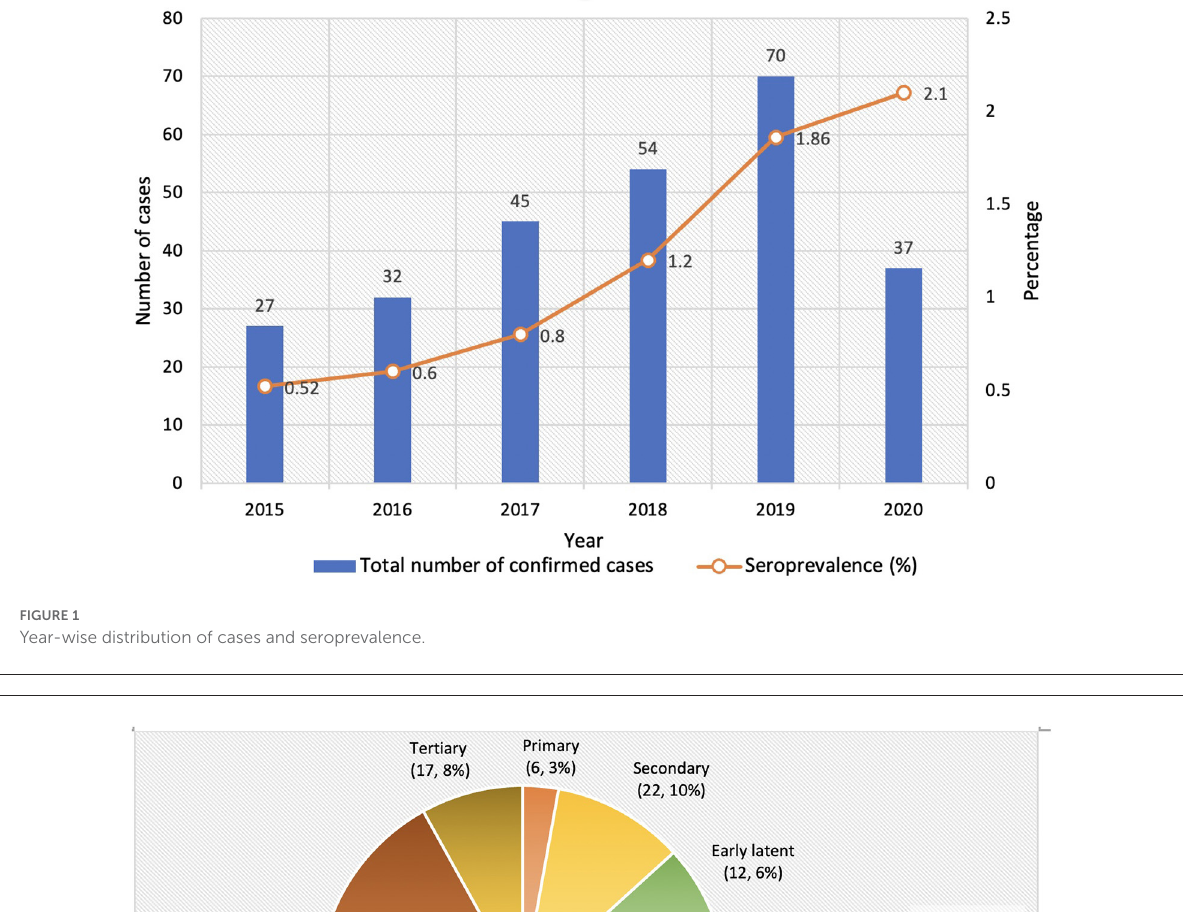
FIGURE1 Year-wise distribution of cases and seroprevalence.